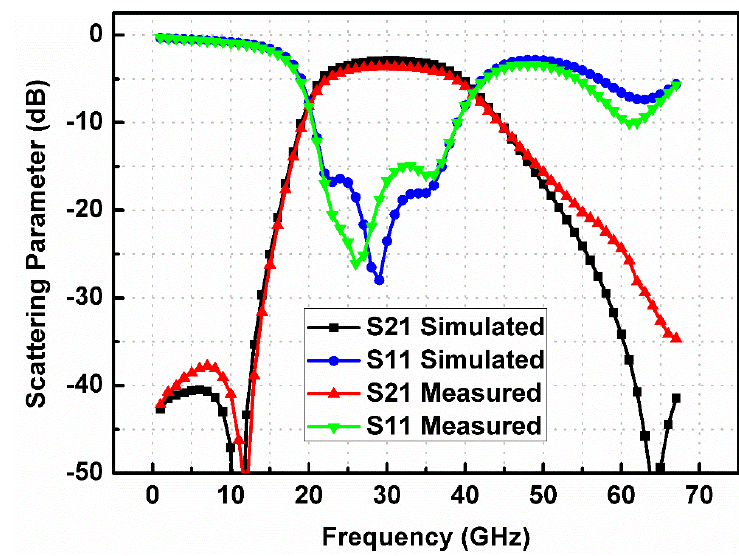
Figure 10. Measurement setup for the proposed BPF.